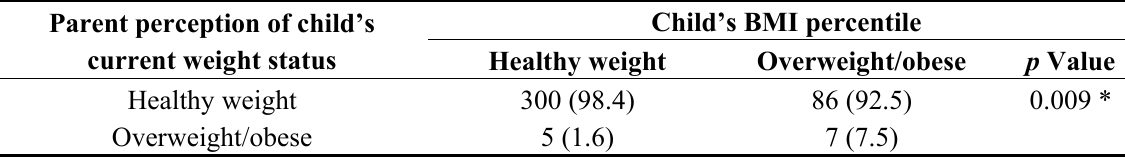
Table 2. Comparison of the number (%) of children by body mass index (BMI) percentile categories and the parental perception of the child’s current weight